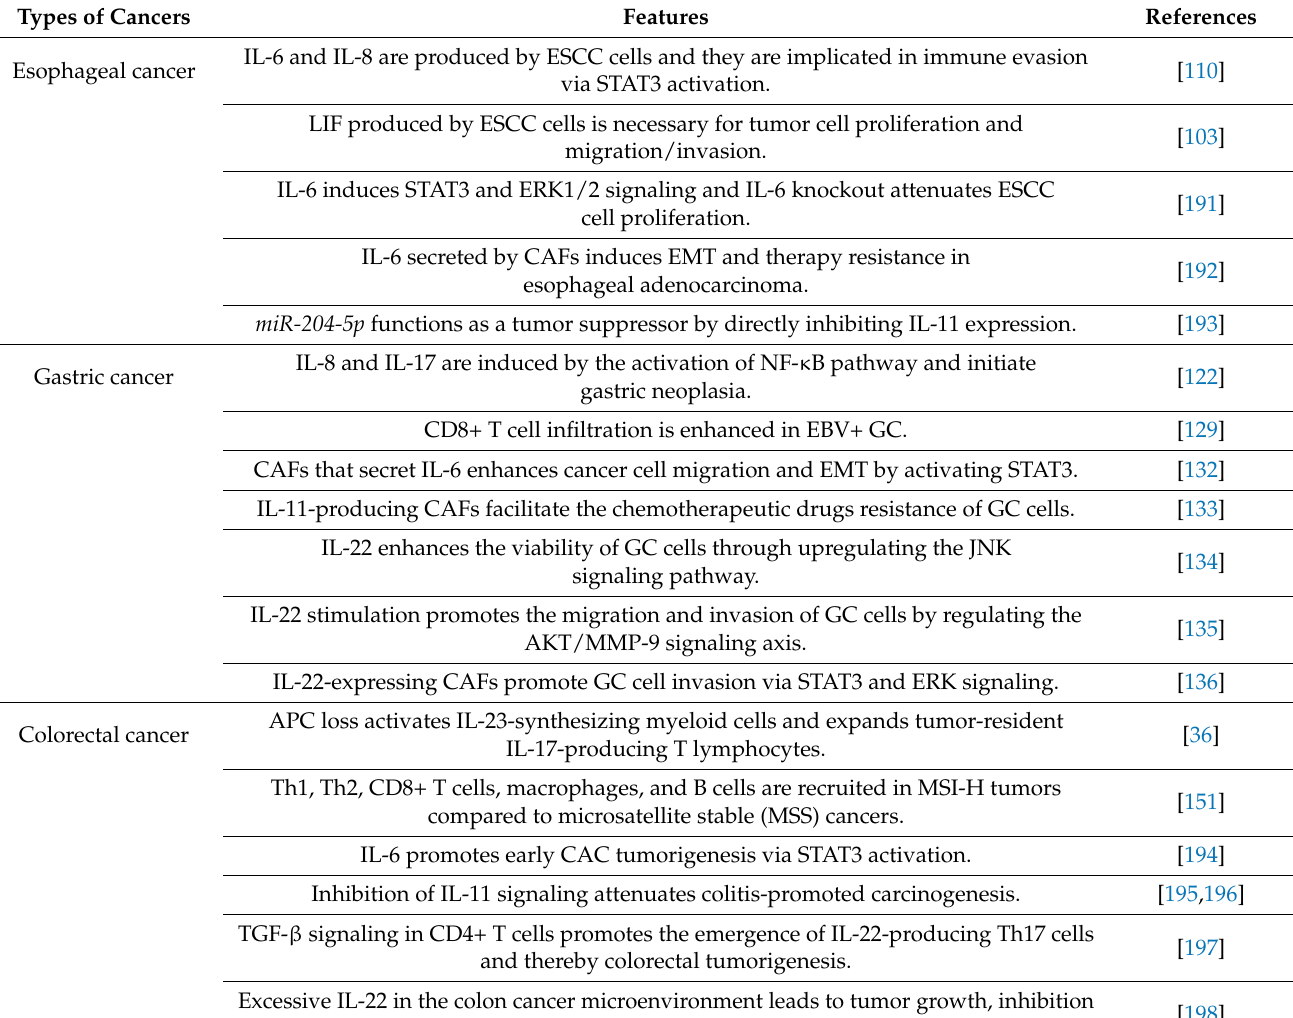
Table 1. Role of inflammation in GI